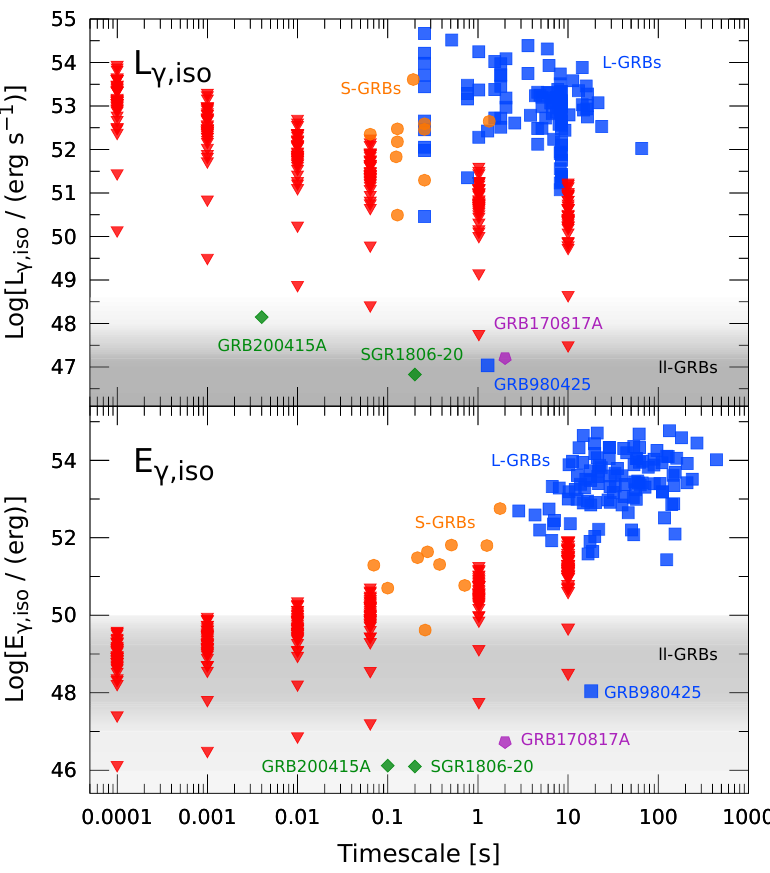
Figure 3. Upper limits (red downward triangles) on both isotropic-equivalent γ -ray luminosity ( top ) and released energy ( bottom ) of prompt counterparts to Fast Radio Bursts (FRBs) as a function of timescale, compared with populations of both short (orange circles) and long (blue squares) Gamma Ray Bursts (GRBs). Also shown are the giant flare from the Galactic magnetar SGR 1806–20, GRB 200415A (the magnetar in NGC 253), the short GRB 170817 associated with the first BNS merger detected with gravitational interferometers, and prototypical low-luminosity GRB980425. In the luminosity plot the GRB 200415A spike duration is assumed 4 ms, whereas the T 90 is 0.1 s [30]. The shaded area shows where most low-luminosity GRBs lie (Figure adapted from